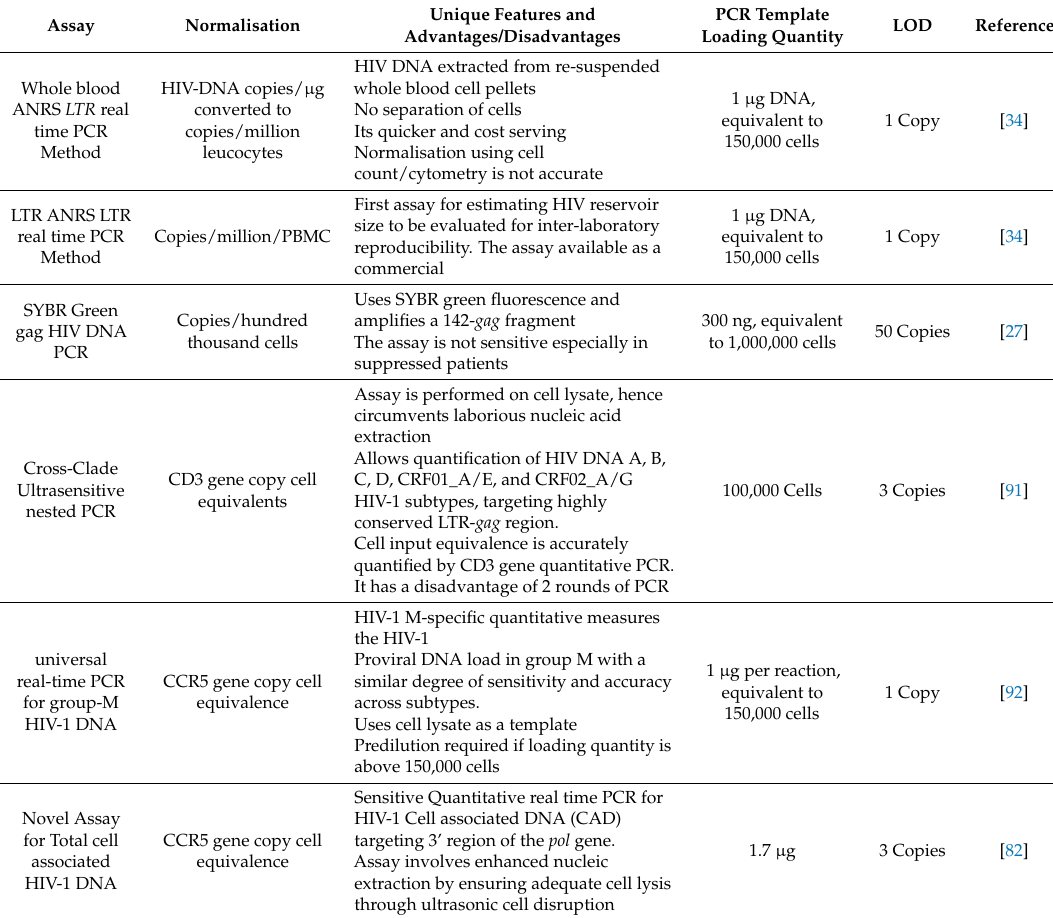
Table 1. Selected technologies used in quantitative HIV DNA real time PCR